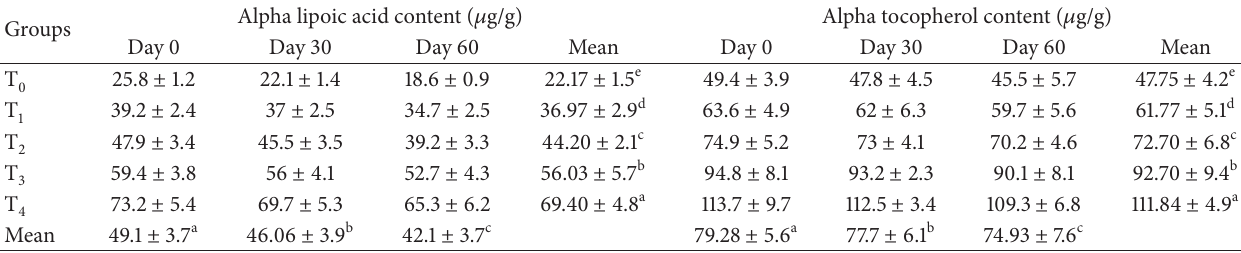
Results are presented as mean ± SD ( 𝑛 = 3), whereas results in the same column with no superscripts in common differ significantly at 𝑃 < 0.01.